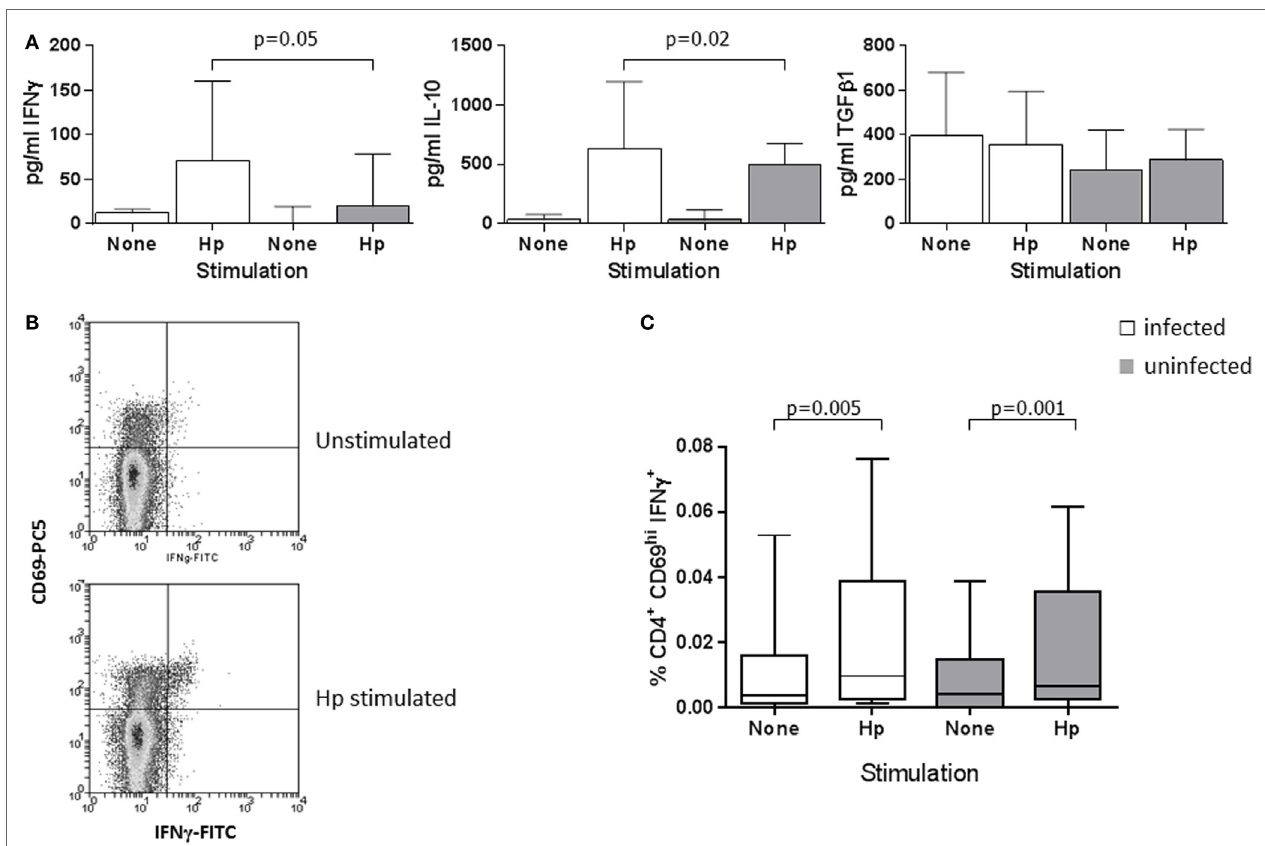
FigUre 1 | Peripheral blood Th1 and Treg cytokine responses in H. pylori -infected and uninfected patients . (a) PBMCs from 13 infected patients (white bars) and 11 uninfected patients (gray bars) were cultured for 48 h in the presence of 25 μ g/ml H. pylori (Hp) lysate, with medium alone as a negative control or with 20 μ g/ml conA as a positive control stimulus. IFN γ , IL-10, and TGF β 1 concentrations were determined using commercial ELISA kits. Bars depict the median and error bars show the 95% confidence interval. Following conA stimulation, median concentrations from the PBMCs of infected and uninfected patients were, respectively, 1885 and 2035 pg/ml IFN γ , 375 and 393 pg/ml IL-10, and 352 and 306 pg/ml TGF β 1. Th1 cells were quantified in PBMCs from 34 infected and 24 uninfected patients using flow cytometry. (B) Example flow cytometry dot plots of gated CD4 + cells from an infected donor, stained for CD69 and IFN γ after culture of PBMCs in medium alone, or with Hp lysate antigen. Quadrant indicates the position of CD69 hi IFN γ + events, with the lower left quadrant containing both CD69-negative and -positive events. (c) The percentage of CD4 + CD69 hi IFN γ + events among PBMC lymphocytes is shown following culture in medium alone (unstimulated) or with Hp lysate antigen. When stimulated with PMA and ionomycin as a positive control stimulus, the median percentages of CD4 + CD69 hi IFN γ + events in PBMCs from infected and uninfected donors were 1.13 and 1.17%, respectively. The percentages of CD4 + CD69 hi IFN γ + events were not significantly different between Hp -stimulated samples from infected and uninfected